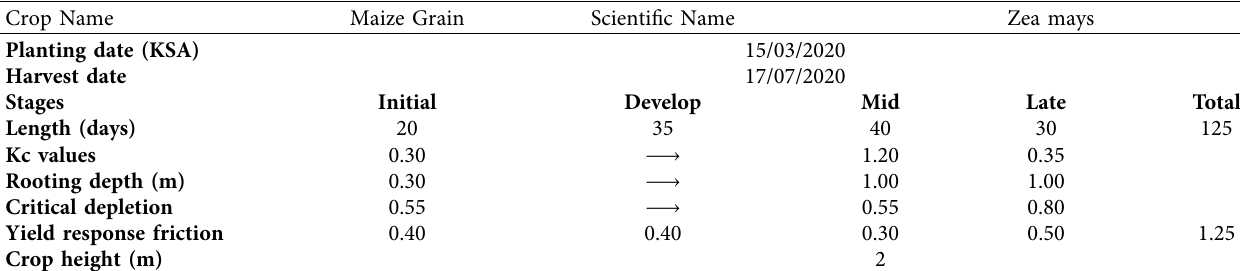
Table 10: The maize grain crop data at various